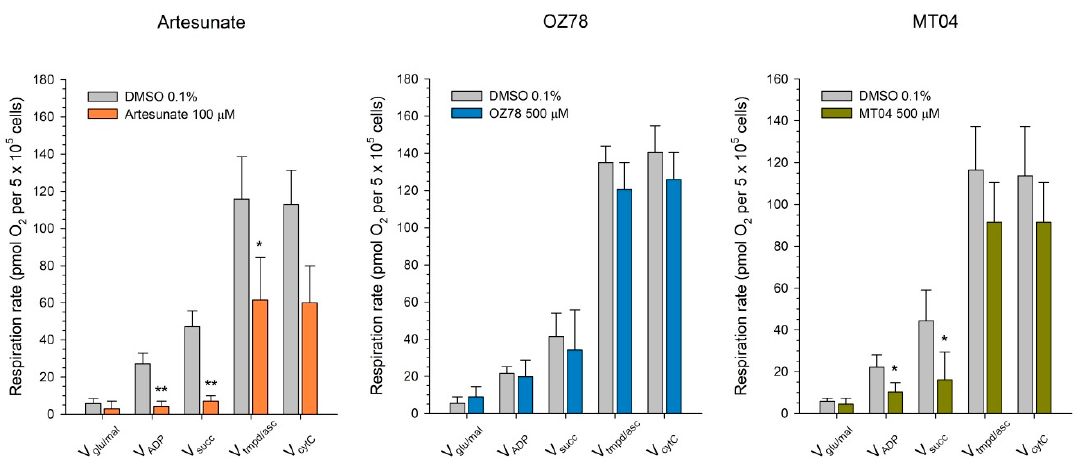
Figure 4. AS and MT04 inhibit different complexes of the mitochondrial respiratory chain. HepG2 cells were treated with AS (100 µM), OZ78 (500 µM) or MT04 (500 µM). After 24 hours, cells were permeabilized with digitonin, and oxygen consumption was measured using the K2 oxygraph (Oroboros). ADP-stimulated respiration rates were compared in the three groups using glutamate (+ malate), succinate (+ rotenone) or N,N,N ′ ,N ′ -tetramethyl-p-phenylendiamine (TMPD) and ascorbate (+ antimycin) as substrates. Results represent the mean of three independent experiments carried out in triplicates. Data represent the mean ± SEM. Asterisks indicate significance compared to DMSO control, * p < 0.05, ** p < 0.01.